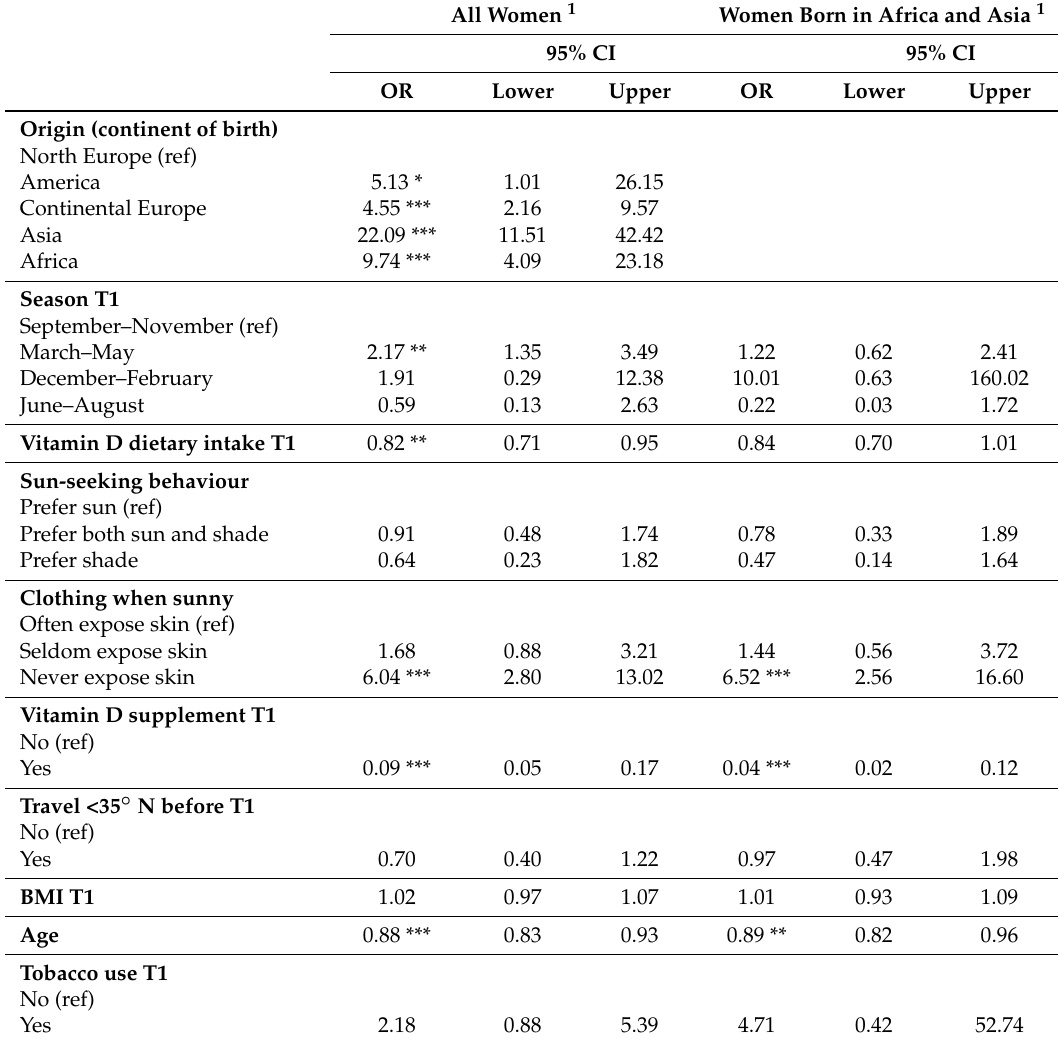
Table 2. Multivariable logistic regression analysis of the determinants of vitamin D deficiency (<30 nmol/L) in the first trimester (T1) of pregnancy. Data is shown for the whole cohort and for the subgroup born in Africa and Asia. All Women 1 Women Born in Africa and Asia 1 95%